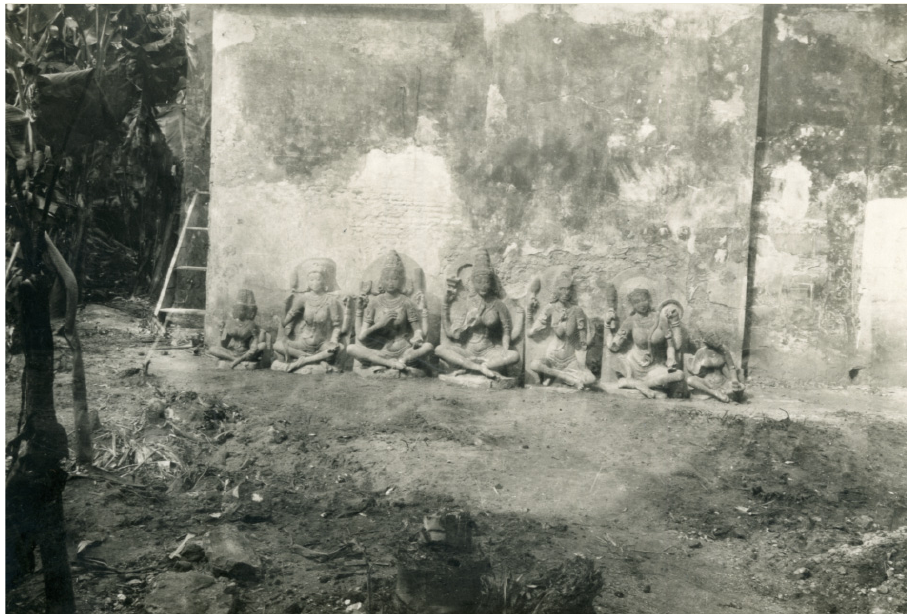
Figure 15. Photograph of yoginis and matrikas from Gabriel Jouveau-Dubreuil. Photograph: Musée Guimet no. 155541/1, reproduced with permission from the Musée Guimet.